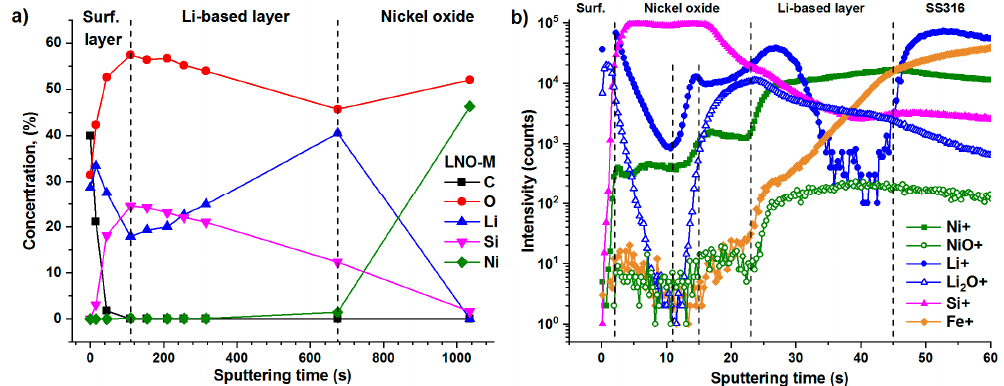
Figure 8. ( a ) X-ray photoelectron spectroscopy depth profiles of the LNO-M and ( b ) time-of-flight secondary-ion-mass spectroscopy (TOF-SIMS) depth profiles of positive ions of the